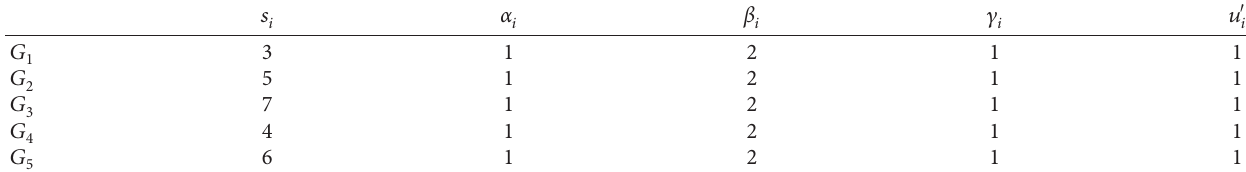
Table 1: Numerical parameters.